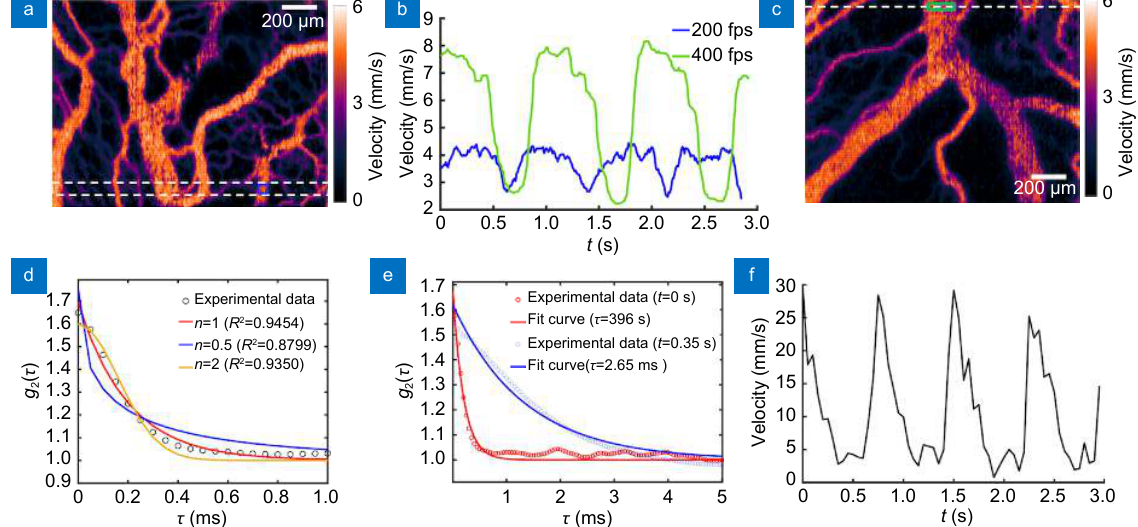
Fig. 3 | LS-LSAI dynamic range and FOV. ( a ) A blood flow velocity image of a chicken embryo (No. 2) scanned at 200 fps for a standard FOV. ( b ) The comparison of time courses of the blood flow in the same regions [enclosed by the blue box in (a)]. Blue and green curves were related to the acquisition frame rate of 200 fps and 400 fps, respectively. ( c ) A time-averaged blood flow velocity image of another chicken embryo (No. 3) scanned at 200 fps. ( d ) The measured intensity temporal autocorrelation function (black circles), which was spatially averaged over a sampling region enclosed by the green box in (c) and fitted curves (solid lines) with models with different n . ( e ) The measured intensity temporal autocorrel- ation function at two different time points (circles), and their corresponding fitted curves (lines) with a model parameter n = 1. ( f ) The time course of the blood flow velocity for the same sampling